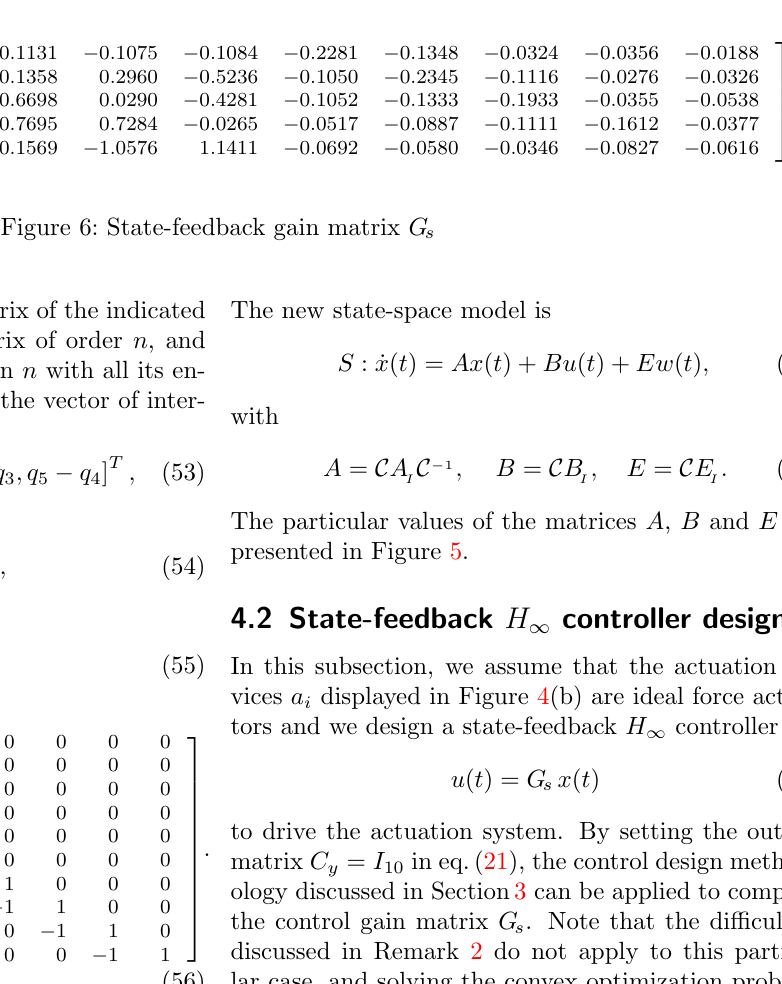
Figure 5: System matrices of the first-order model with interstory drifts and interstory velocities as state variables